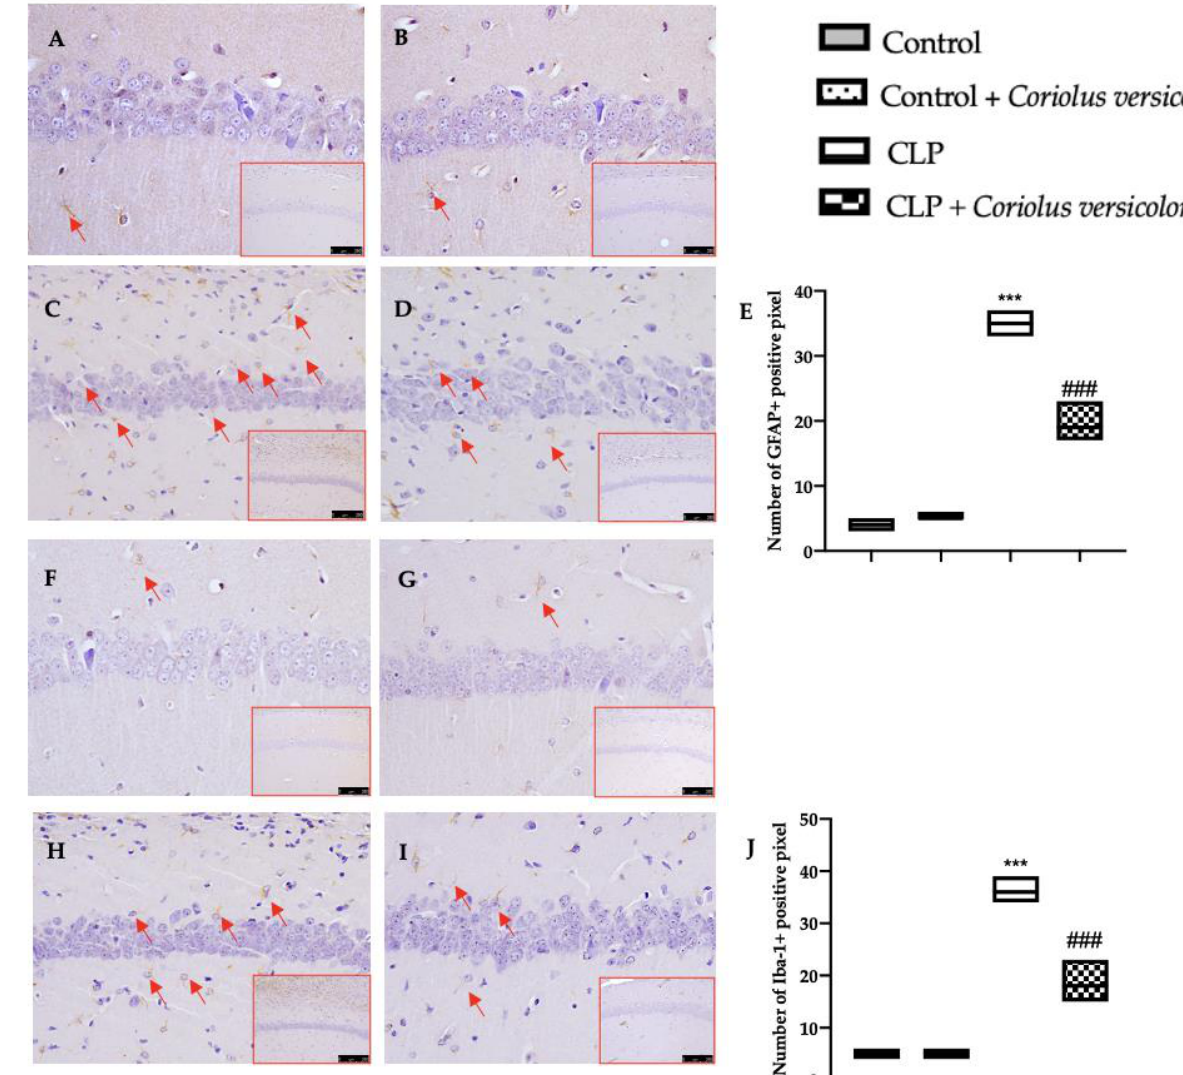
Figure 6. Coriolus versicolor reduced glia activation in hippocampus induced by CLP 28 days after surgery. Immunohistochemical analysis of glial fibrillary acidic protein (GFAP): Control ( A ), Control + Coriolus versicolor ( B ), CLP ( C ), CLP + Coriolus versicolor ( D ), graphical quantification of GFAP expression ( E ); immunohistochemical analysis of Ionized calcium-binding adapter molecule1 (Iba-1): Control ( F ), Control + Coriolus versicolor ( G ), CLP ( H ), CLP + Coriolus versicolor ( I ), graphical quantification of Iba-1 expression ( J ). *** p < 0.001 vs. control, ### p < 0.001 vs. CLP.